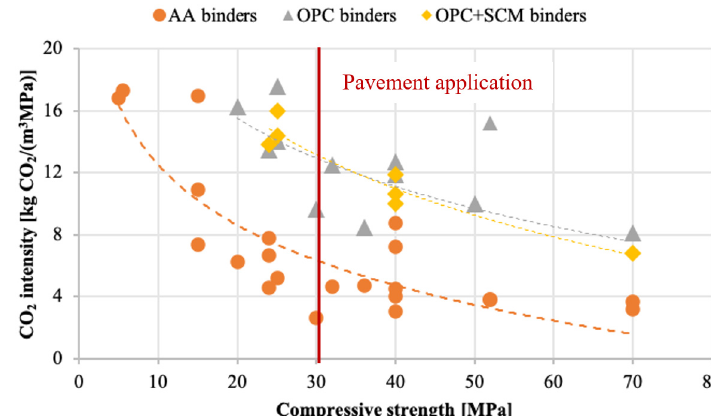
Fig. 3. CO 2 intensity as a function of compressive strength. Data from published LCA literature [13 ‐